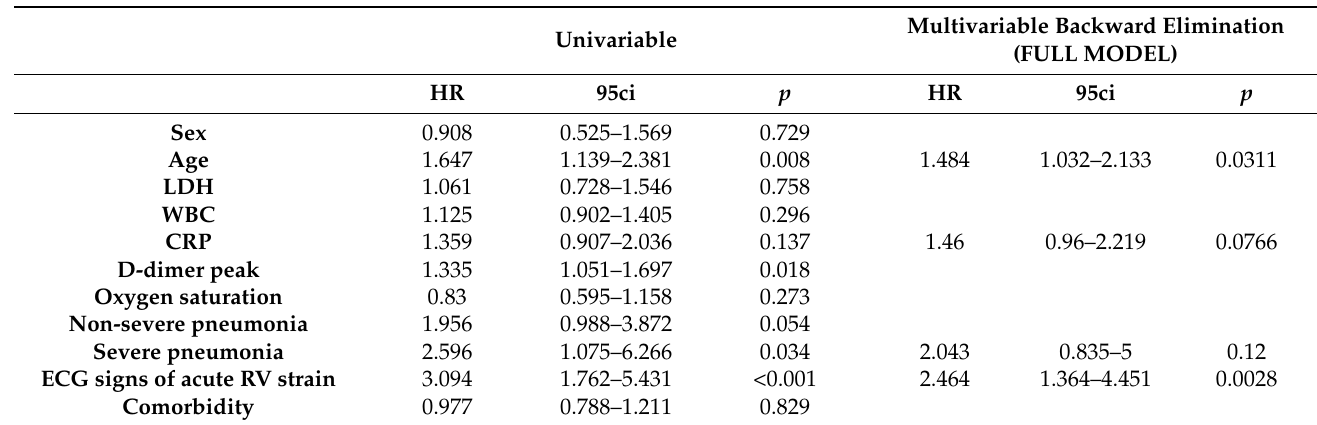
Table 3. Univariate and multivariable Cox regression analyses.